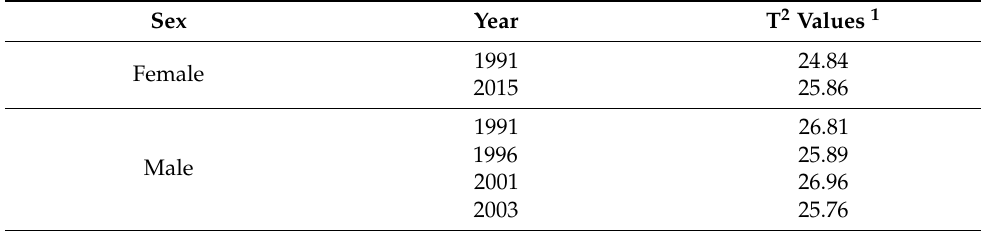
Table 3. T 2 values for the